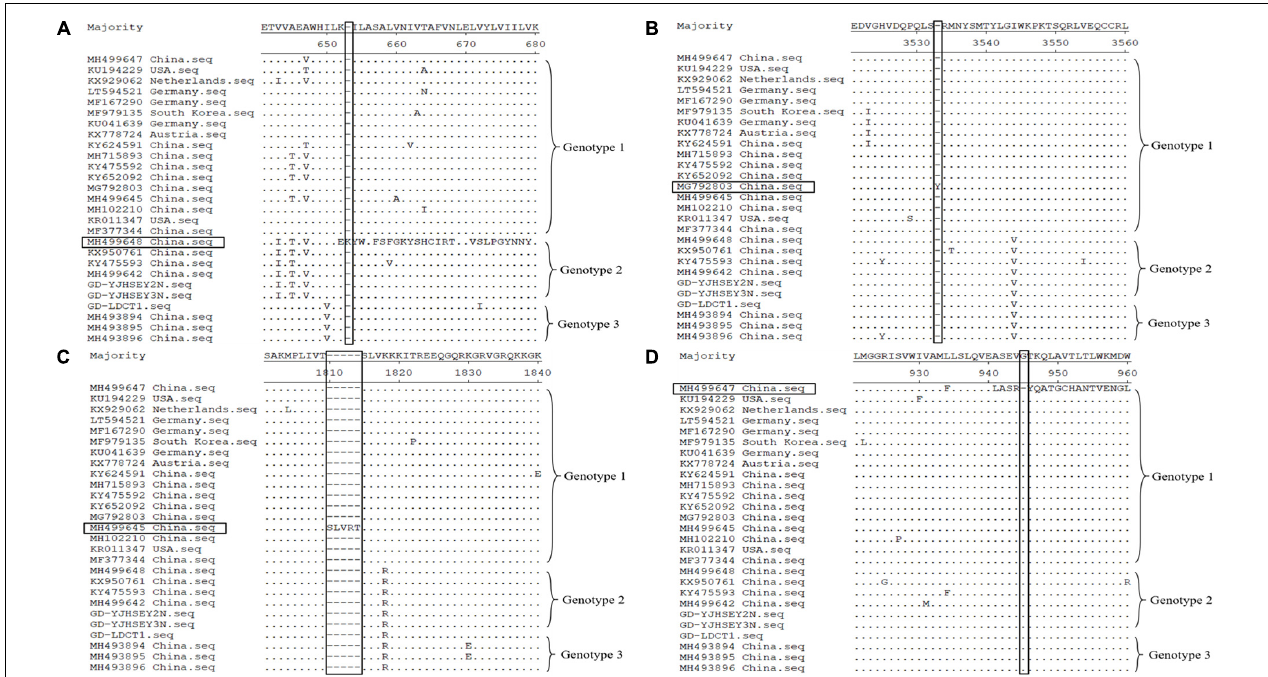
FIGURE 1 | Polyprotein amino acid of APPV alignment by Megalign software available in DNASTAR (http://www.dnastar.com/). Amino acid deletion and insertion regions of the four reference sequences are indicated using rectangular boxes. (A) MH499648 (genotype 2) has a lysine inserted at position 653 of the polyprotein. (B) MG792803 (genotype 1) has a tyrosine inserted at position 3533. (C) MH499645 (genotype 1) has five amino acids (serine, leucine, valine, arginine, and threonine) inserted at position 1810. (D) MH499647 (genotype 1) with a deletion of glycine at position